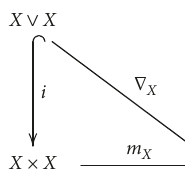
Figure 17: A commutative diagram.